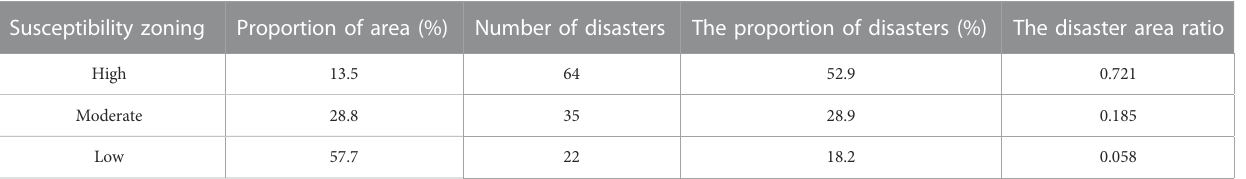
TABLE 4 The disaster area ratio of EWM-IV model evaluation